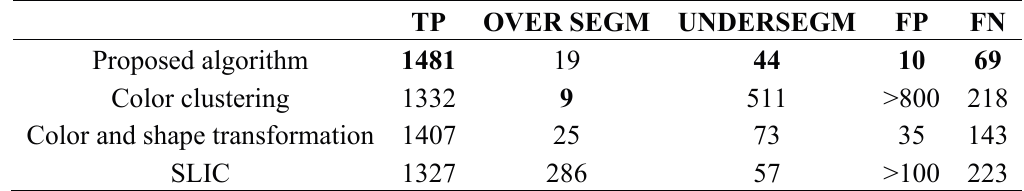
Table 3. Quantitative comparison of four algorithms.